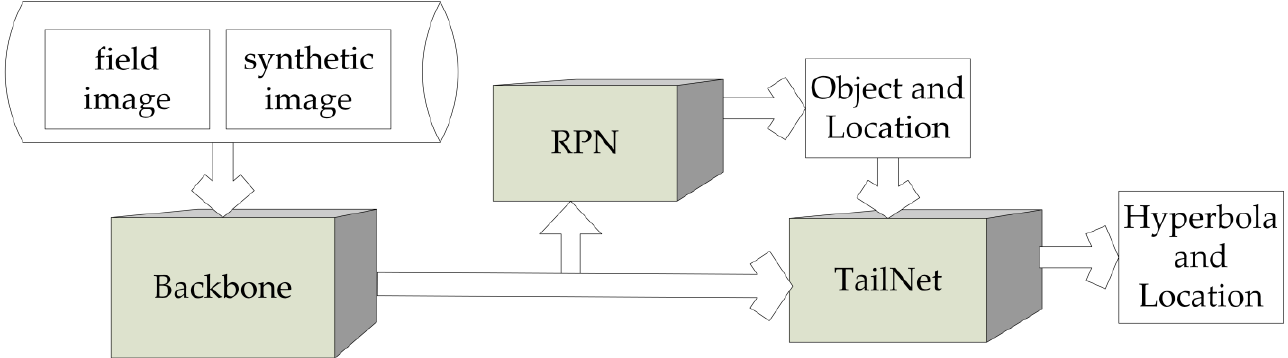
Figure 3. The framework of hyperbola region detection with Faster RCNN (Regions with CNN features). RPN: Region proposal network.